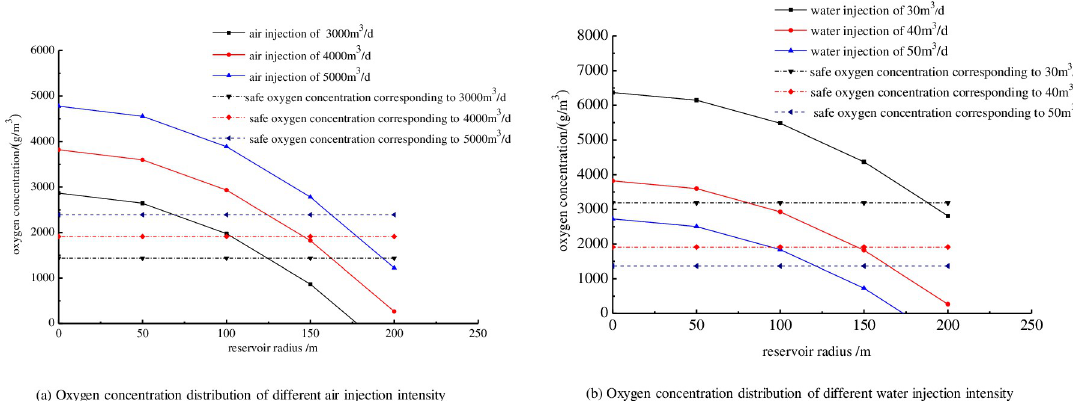
Fig 12. Oxygen concentration distribution of different injection intensity.